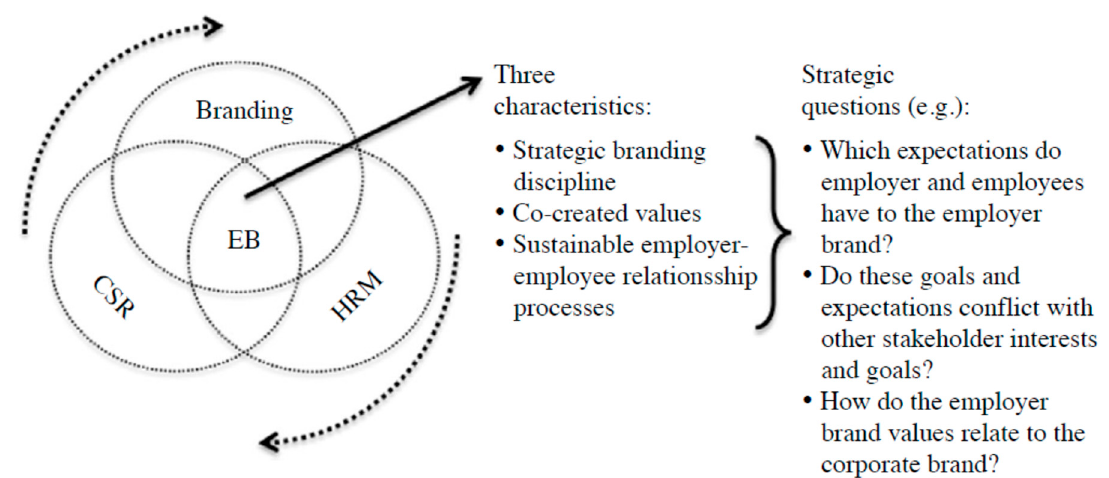
Figure 2. The framework of employer branding (Aggerholm et al. 2011).